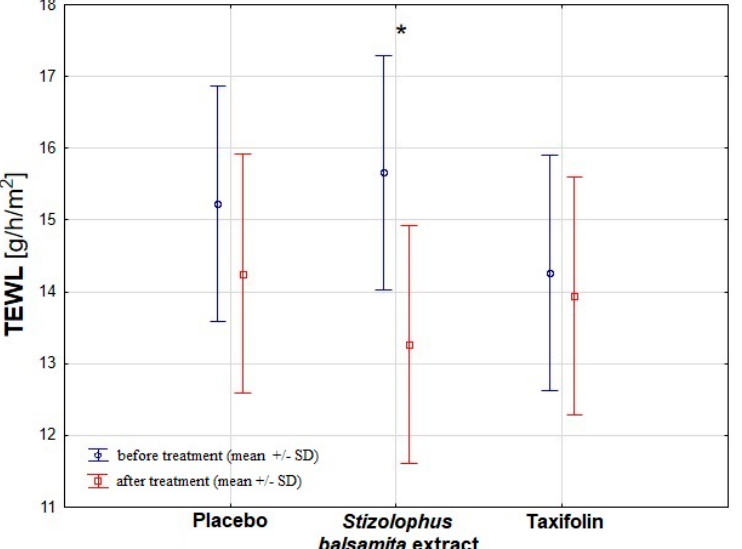
Figure 3. The comparison of skin TEWL results between examined groups. The results are expressed as the mean ± standard deviation (SD). Descriptions: *—statistically significant for Stizolophus balsamita extract before and after treatment.